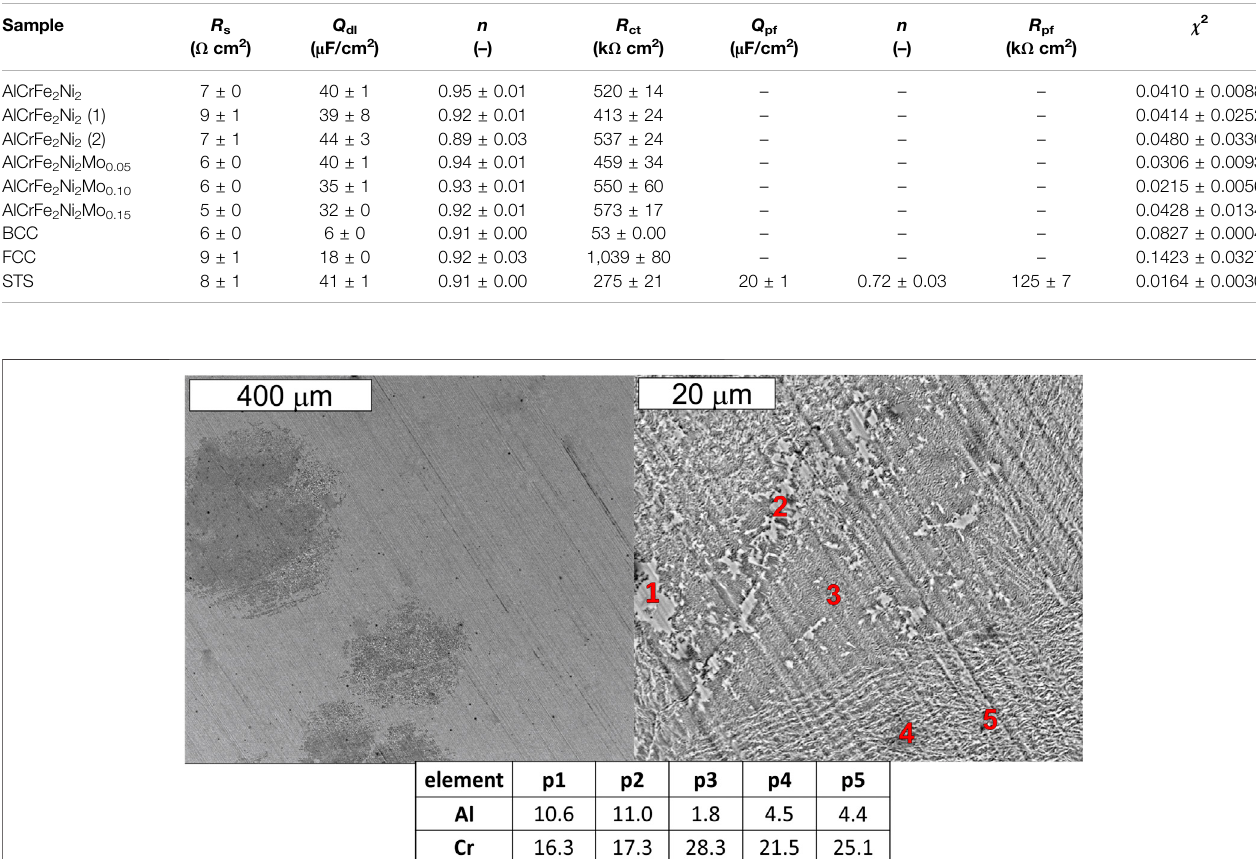
Frontiers in Materials |